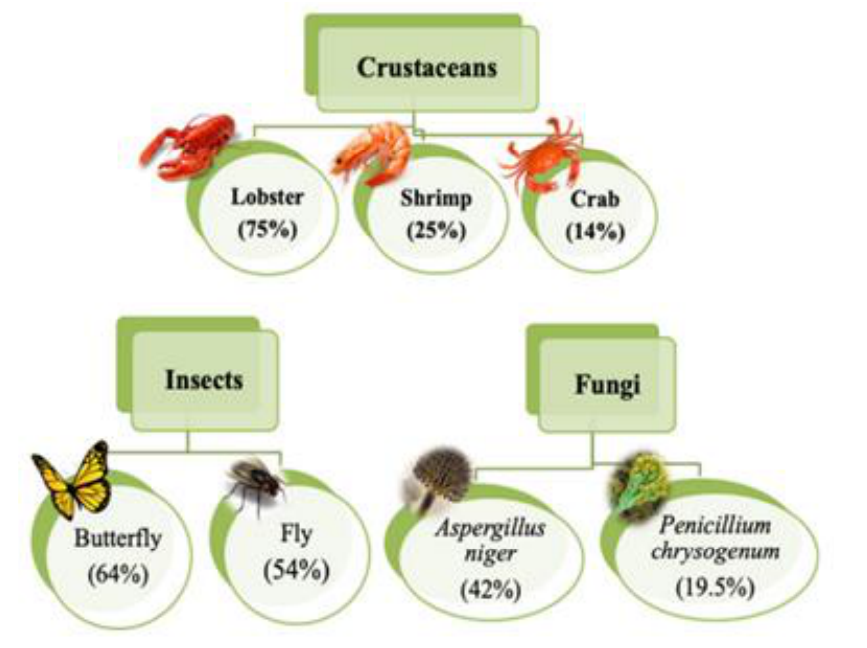
Figure 3. Chitin content can be observed in various sources [15].